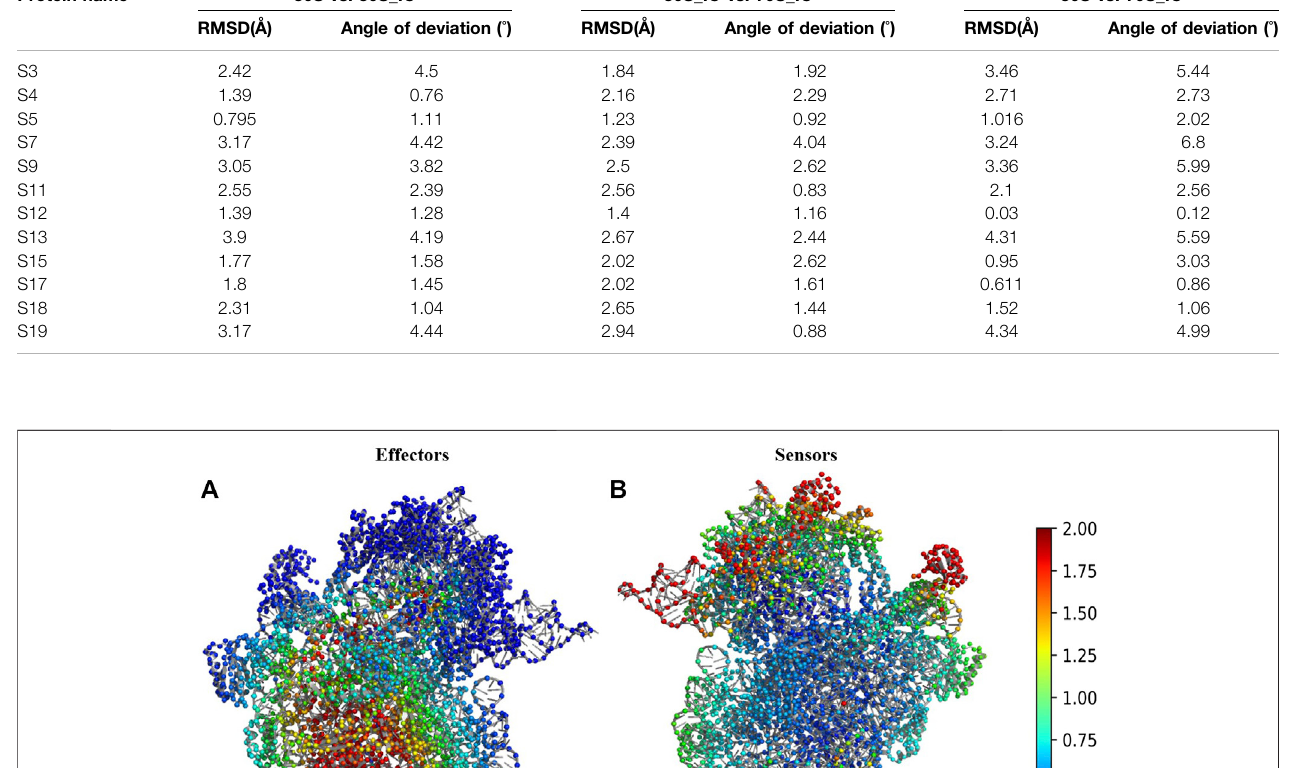
TABLE 1 | Calculation of root mean square deviation (RMSD) and angle of deviation among proteins of 30S complex. Protein name